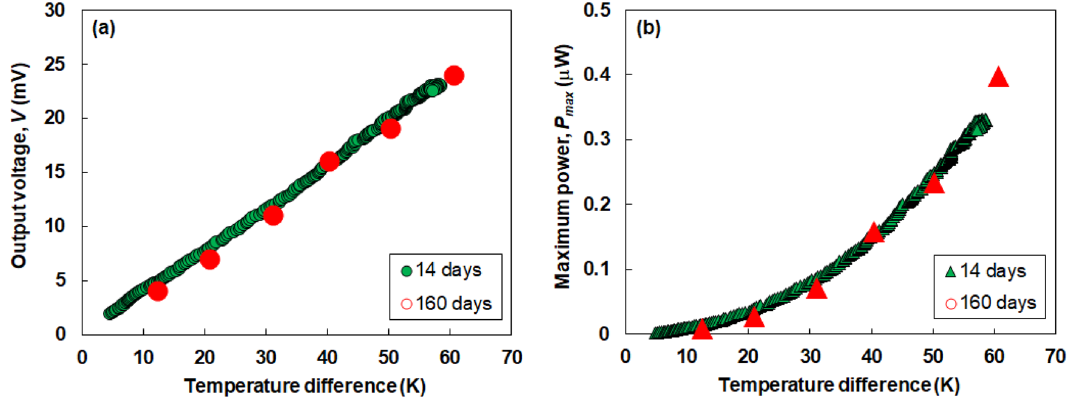
Figure 5. Performance of all-carbon TEG measured at 14th and 160th days after the TEG fabrication. ( a) Output voltage and ( b) maximum